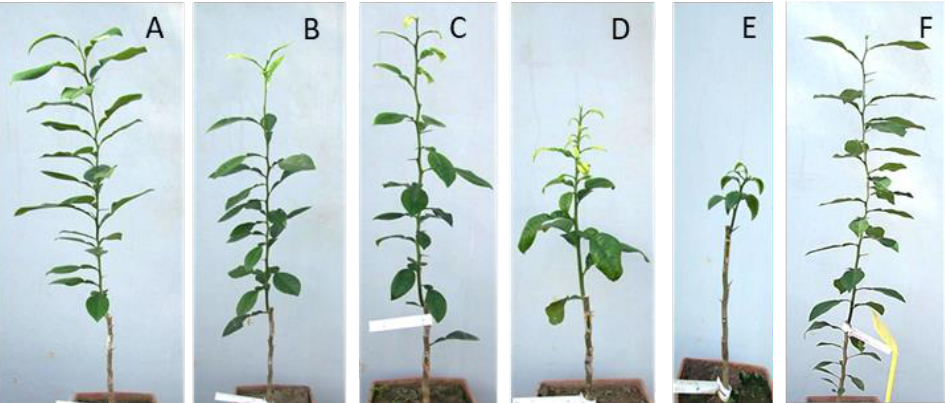
Figure 4. Symptomatic responses of sour orange seedlings inoculated with Mac39 ( A ), Mac101 ( B ), Mac25 ( C ), P3R1 ( D ), P3R3 ( E ), 6 months post-inoculation in comparison to non-inoculated control ( F ).